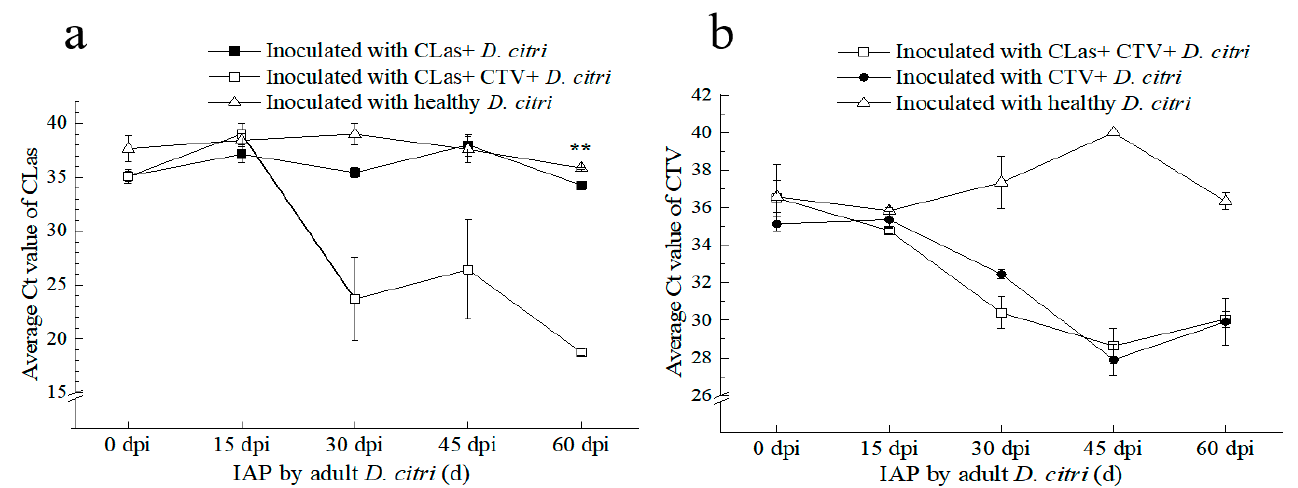
Figure 6. Transmission effect of ‘ Candidatus Liberibacter asiaticus’ (CLas) and/or Citrus tristeza virus (CTV) by D . citri to Citrus reticulata Blanco “Shatangju” plants. ( a ) Ct values of CLas detection in “Shatangju” samples after inoculation access period (IAP) by D . citri carrying different pathogens. ( b ) Ct values of CTV detection in “Shatangju” plants after IAP by the D . citri carrying di ff erent pathogens. CLas+: CLas positive; CTV+: CTV positive; CLas+ & CTV+: CLas positive and CTV positive. **: Independent sample t -test and Duncan’s Multiple Range test to determine statistical signi fi cance within a 99% con fi dence interval ( p = 0.01).